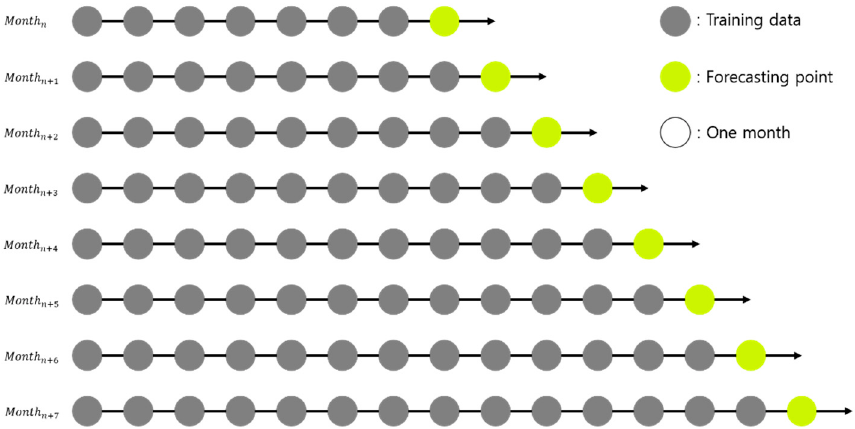
Figure 4. Example of monthly time-series cross-validation.